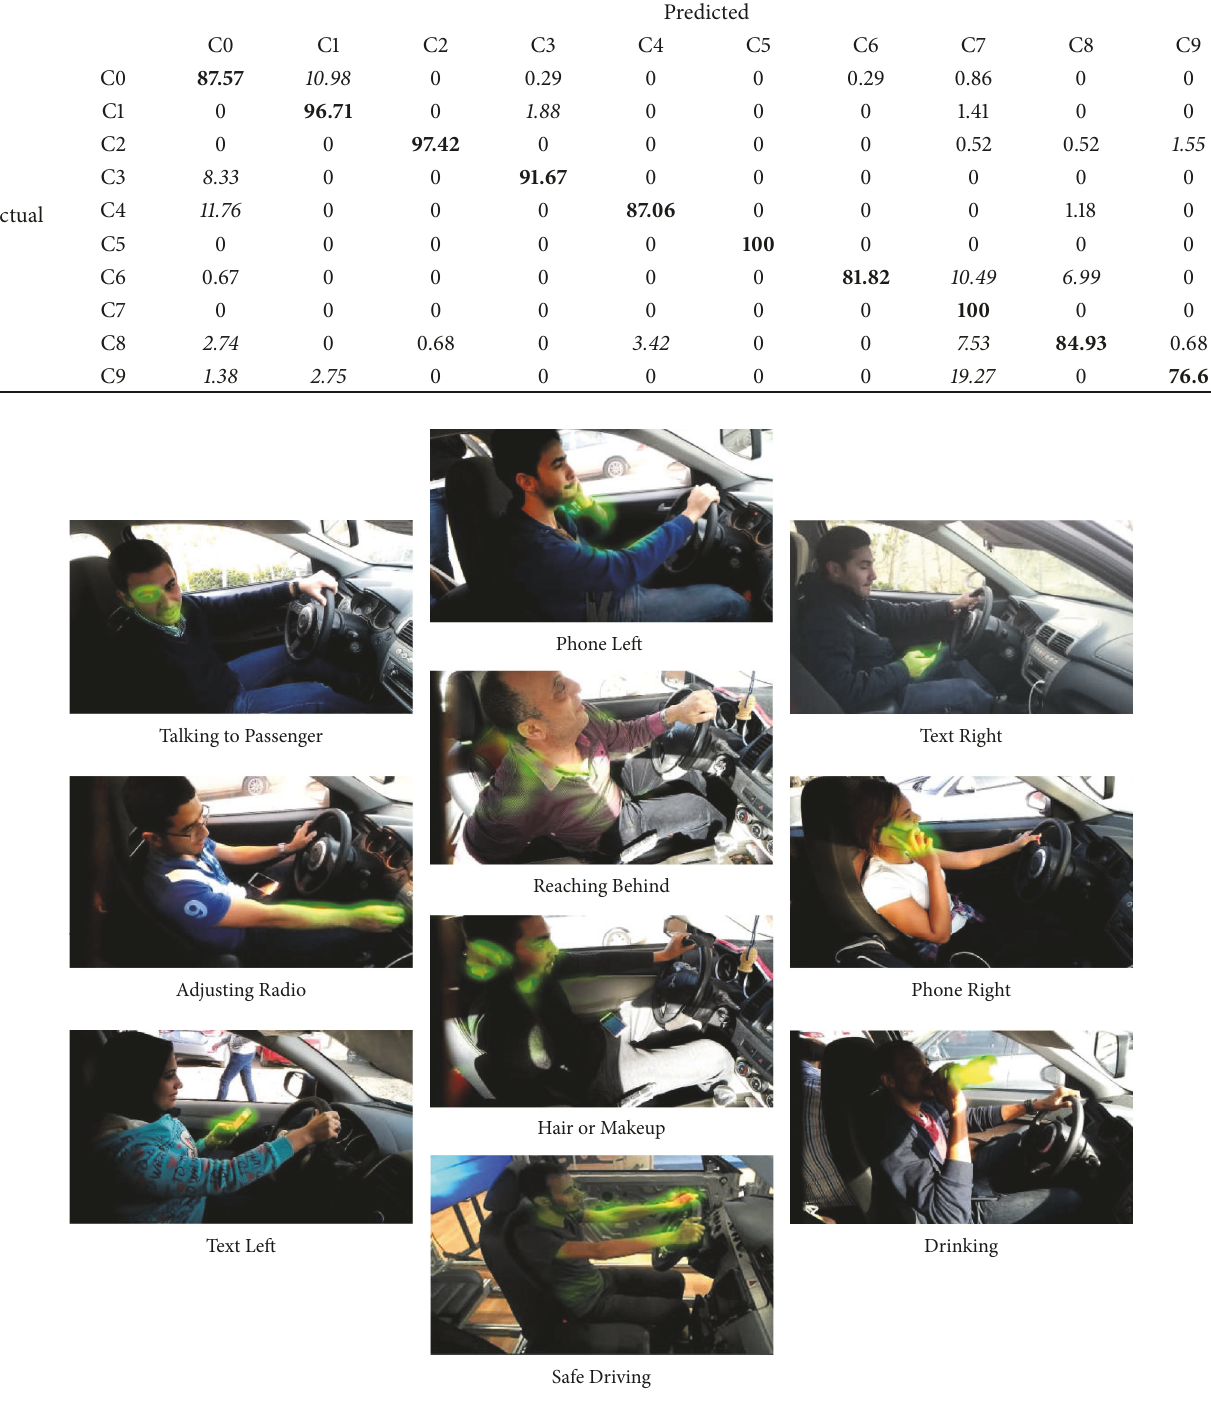
Figure 7: Saliency map demonstrates that our network makes its decision based on relevant features/regions in the input camera images. identification decision based only on the current